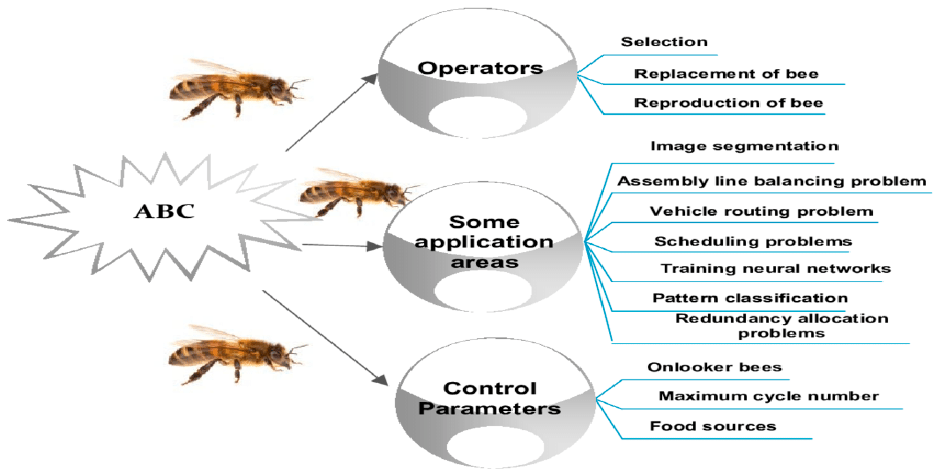
Figure 8. Artificial bee colony [69].